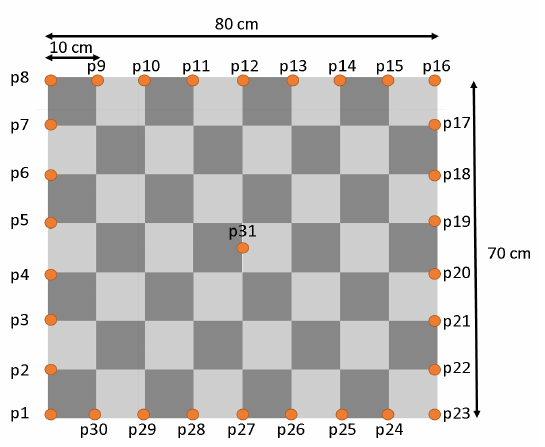
Figure 4. Grid measuring